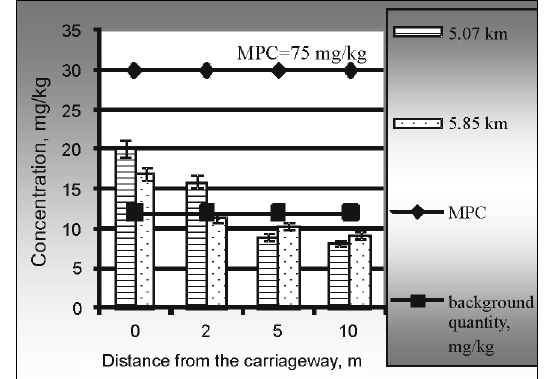
Fig. 8. Nickel concentration in the roadside soil of the